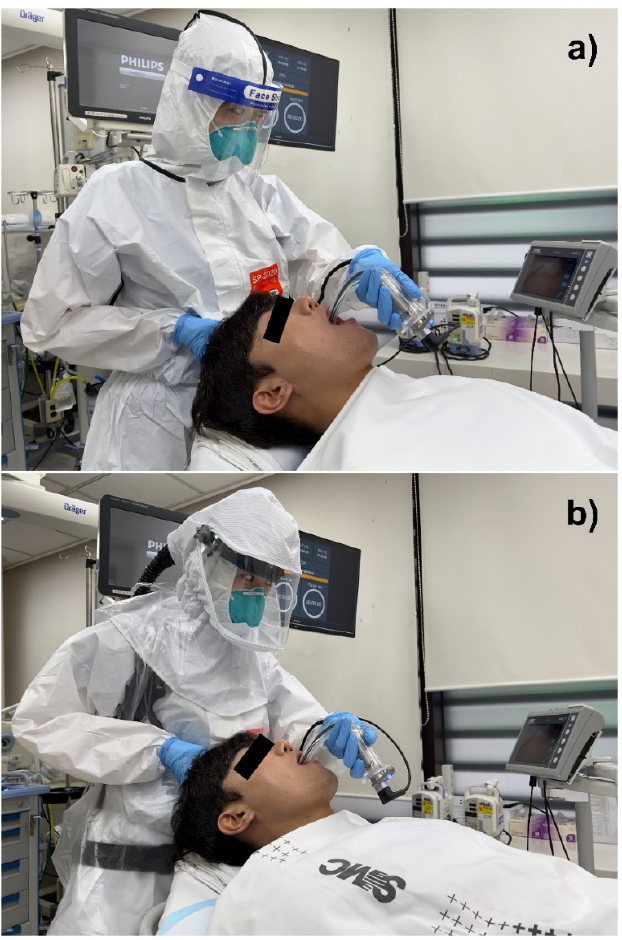
Figure A1. Level of PPE: ( a ) general PPE; ( b ) enhanced PPE. PPE, personal protective equipment. These are staged photographs taken with the consent of the participants.